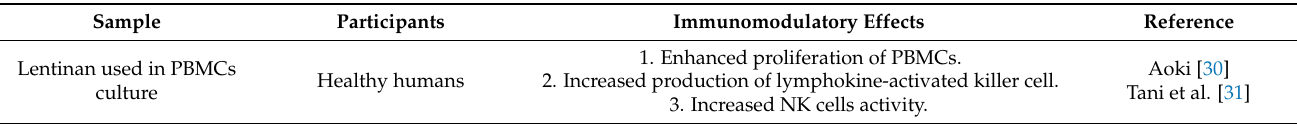
Table 2. Main studies of immunomodulatory effects of L. edodes polysaccharides in